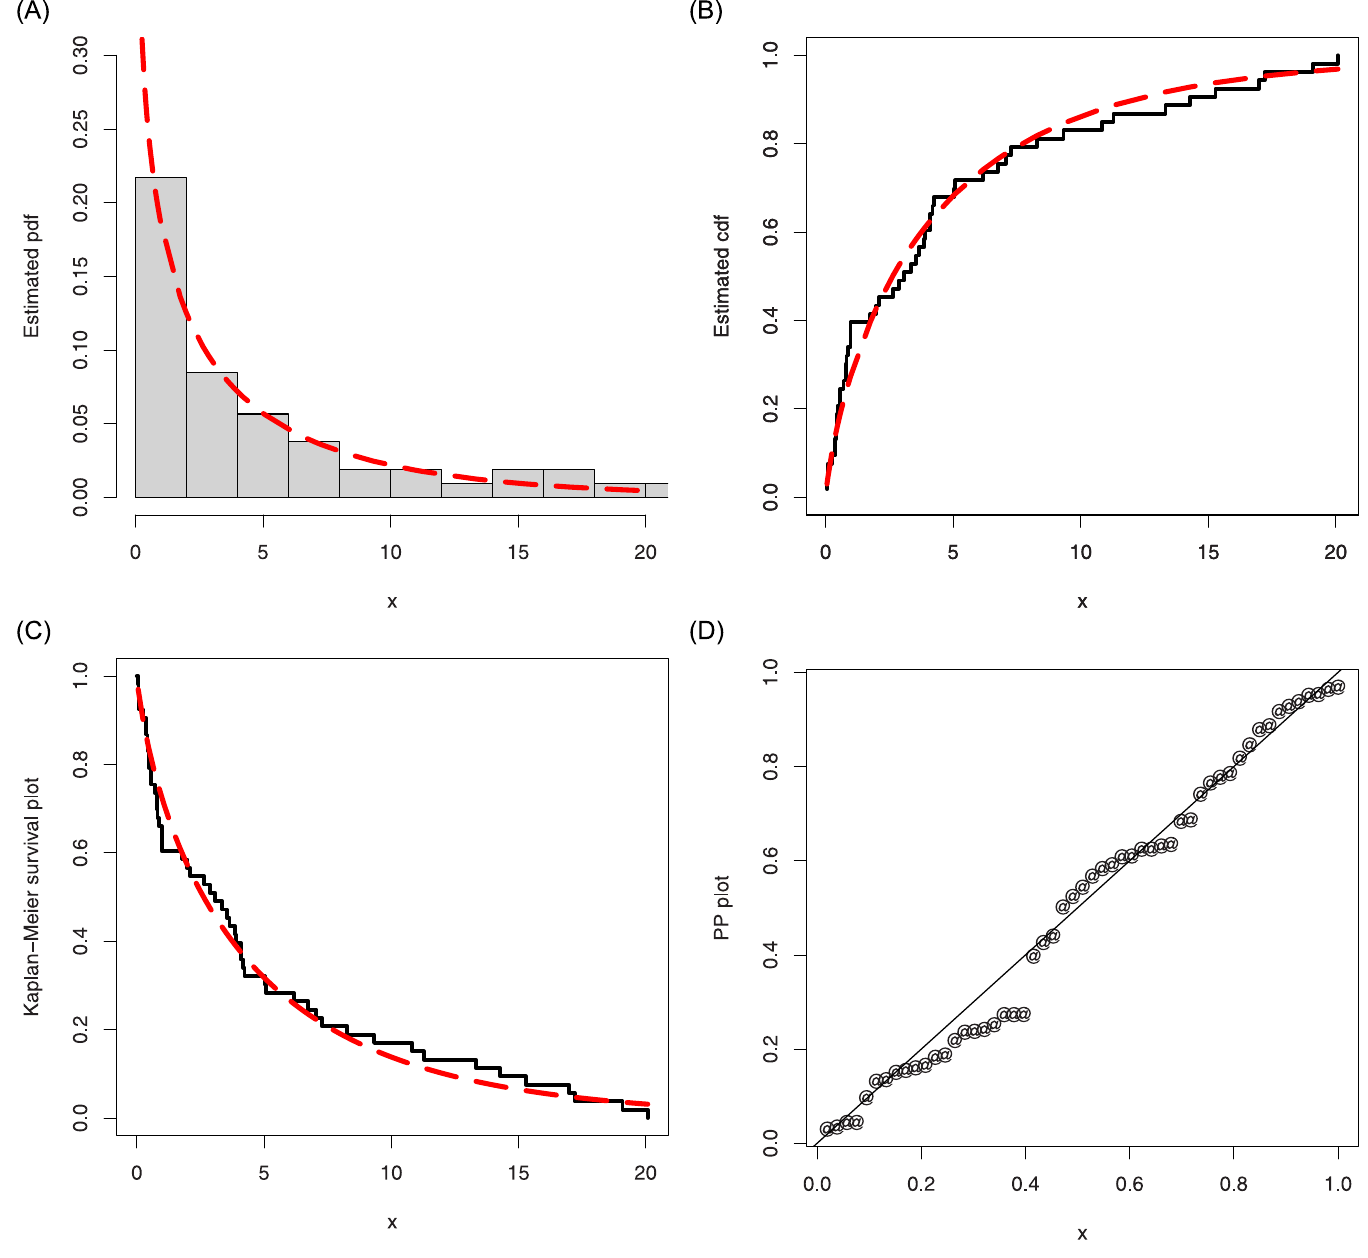
Fig 14. The estimated pdf, cdf, PP and Kaplan-Meier survival plots of the ASM-Weibull distribution for the COVID-19 data.